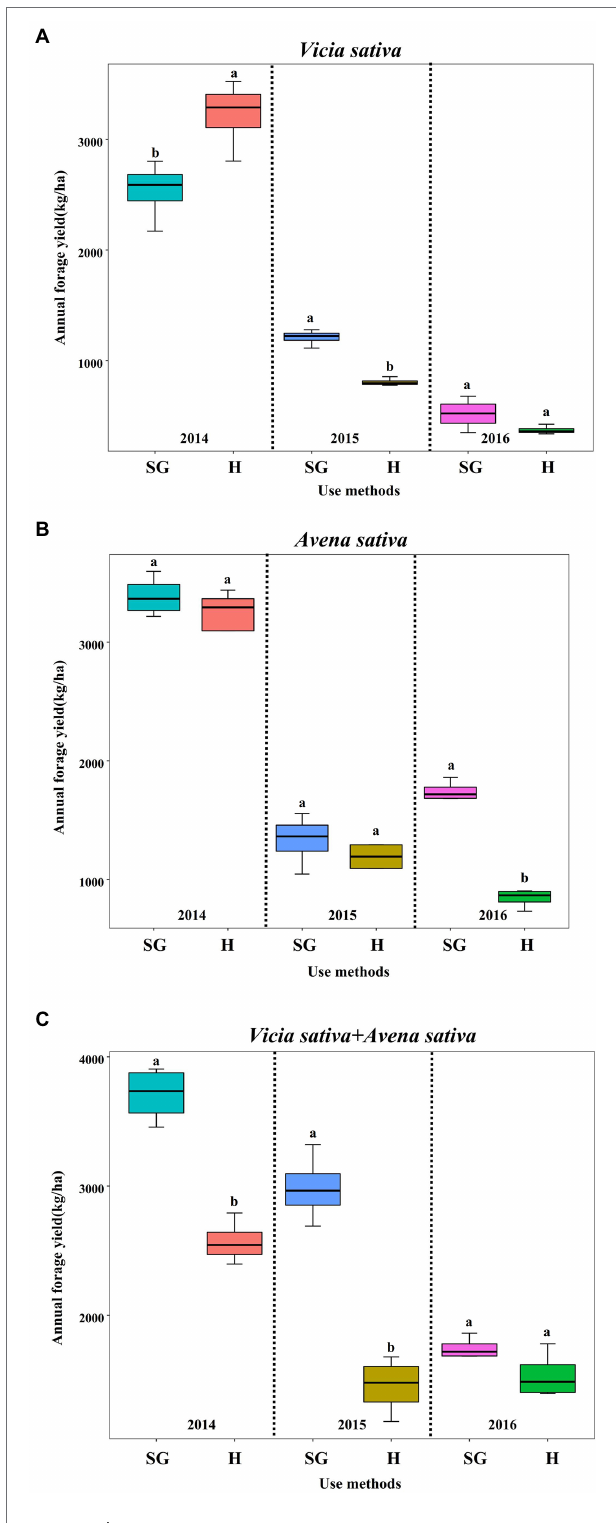
FIGURE 4 | Response of annual forage yield (kg/ha) of three forage crops to different use methods (SG: simulated grazing and H: harvesting hay) in 2014– 2016. (A) Vicia sativa, (B) Avena sativa, (C) Vicia sativa +Avena sativa. Different small letters indicate significant differences ( p < 0.05), and other cases with the same letter or no letter showed no significant difference ( p >